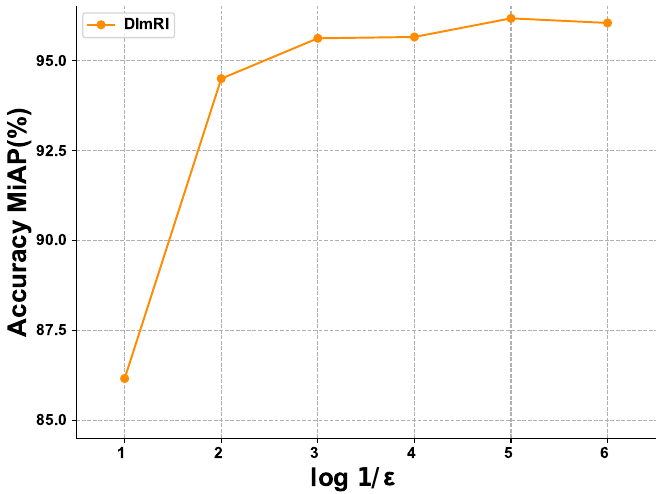
Figure 9. The figure shows the effect of (cid:101) on the MiAP score using our DlmRl.